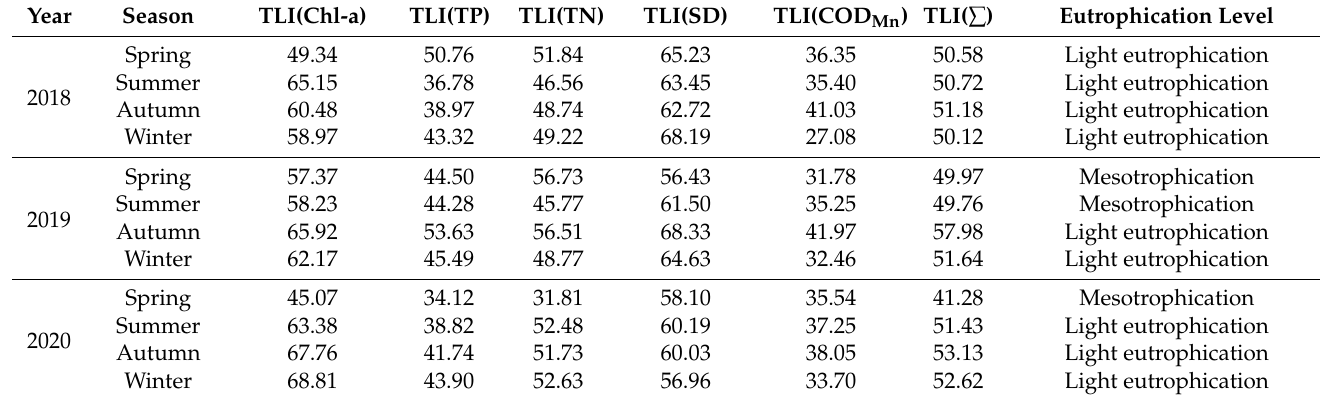
Table 1. Assessment of waterbodies by the trophic level comprehensive index.